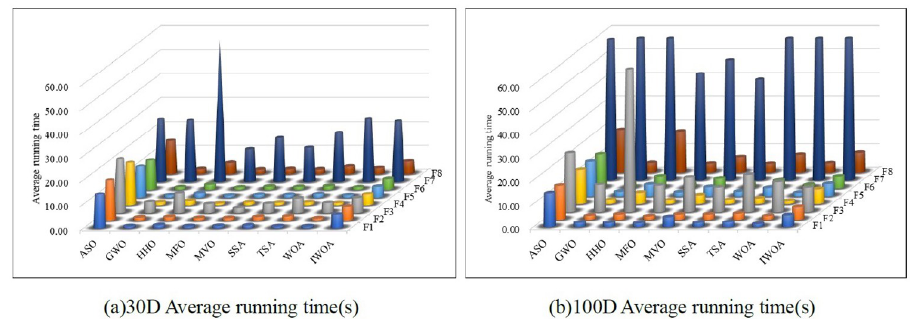
Fig 7. Average running time of different algorithms. (a) 30D Average running time(s), (b) 100D Average running time(s).